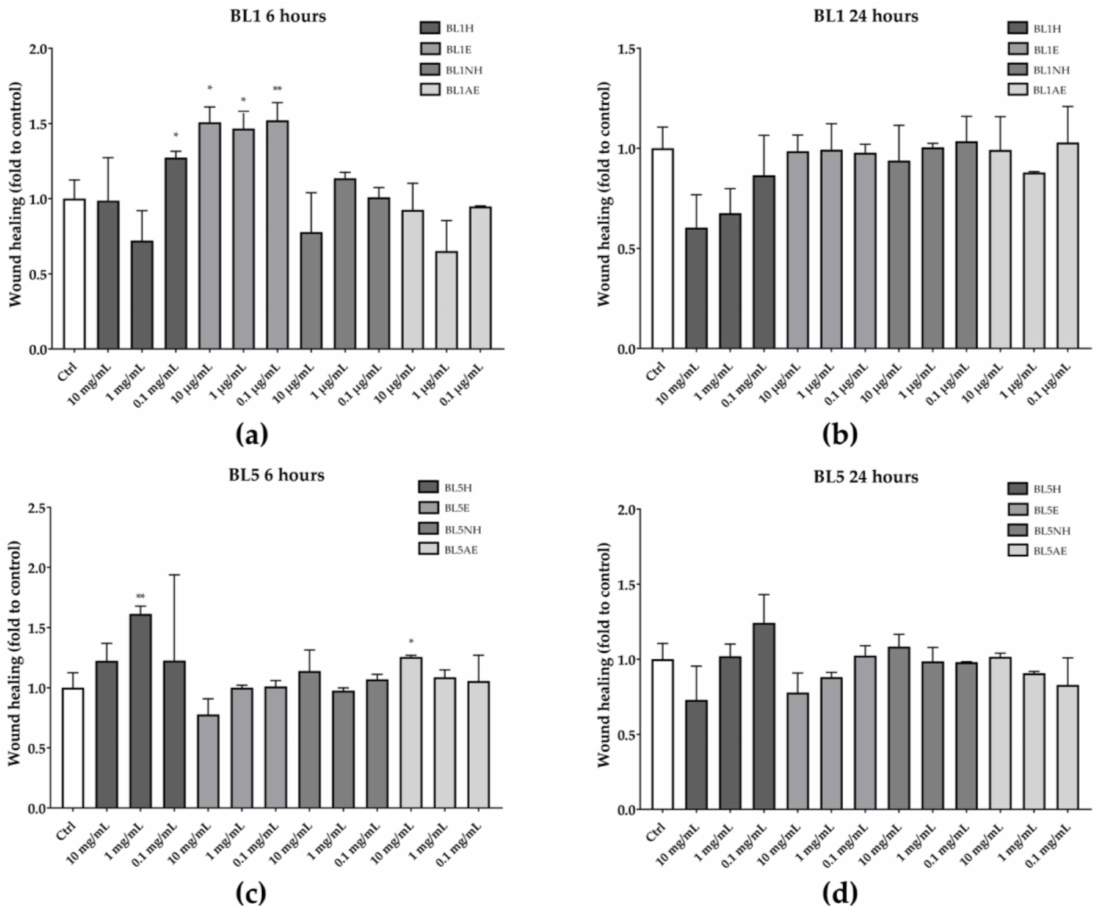
Figure 3. Wound-healing activity of BL1 ( a , b ) and BL5 ( c , d ) honeys and extracts after six hours (left) and 24 hours (right). * p < 0.05 vs. control; ** p < 0.01 vs. control. As reported in Figure 4, BL2, BL3, and BL4 were not effective in increasing the HaCaT wound healing at each time